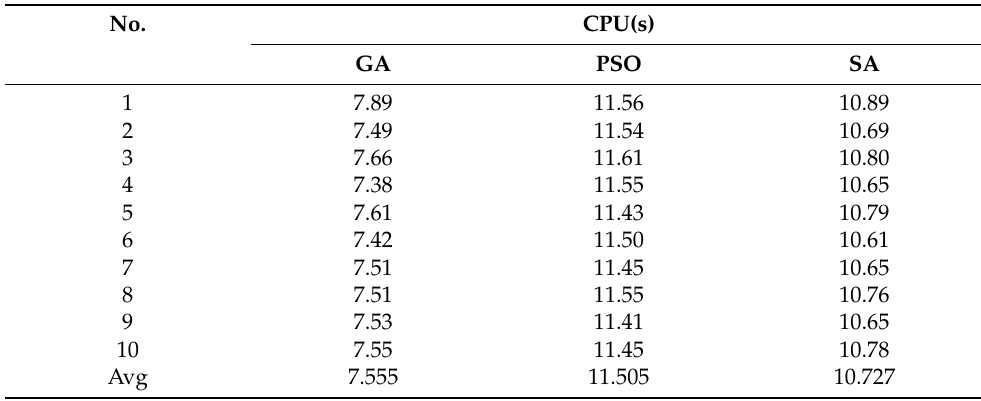
Table 4. Comparison of the CPU time required for different algorithms.